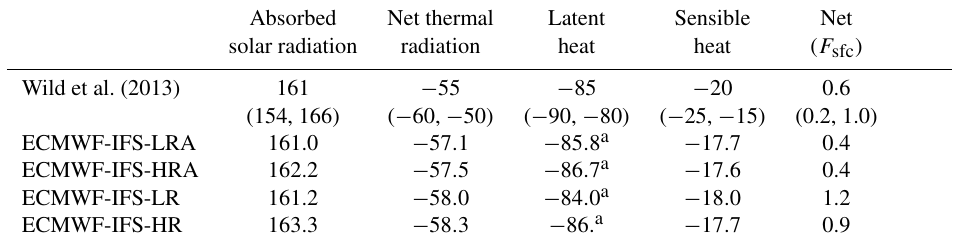
Table 2. Radiative and turbulent energy fluxes at the lower boundary of the atmosphere in observations representative of the early 21st century (Wild et al., 2013) and model experiments for the period 2000–2014. Fluxes are positive downwards and expressed in Wm − 2 relative to Earth’s surface area. Values in parentheses represent the range of uncertainties given by Wild et al. (2013). Absorbed